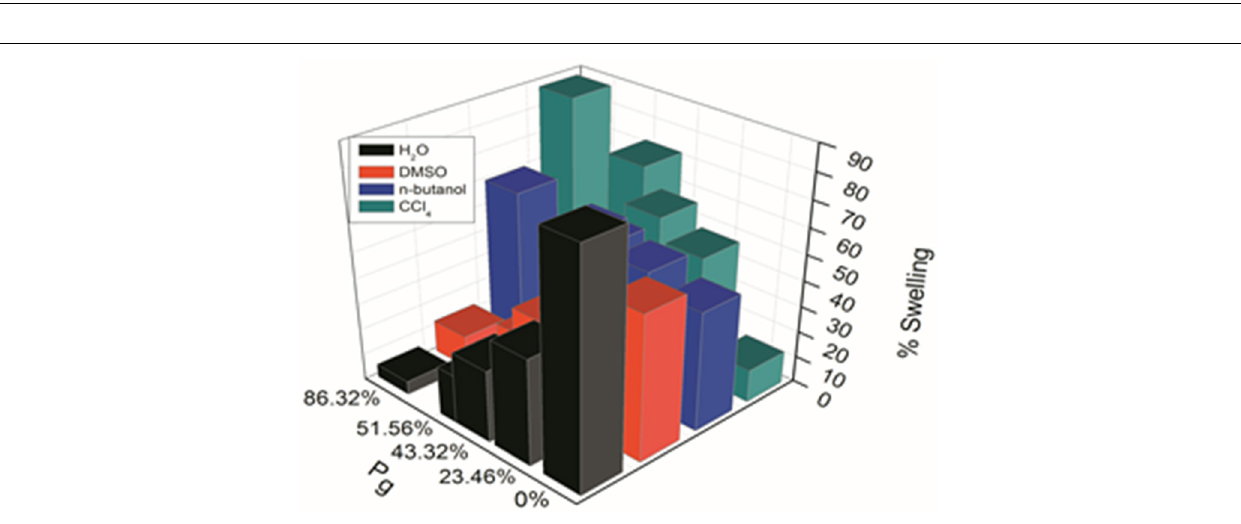
Figure 2 | Swelling behavior of delignified Grewia optiva fiber, dGo-poly(MMA), dGo-poly(MMA-co-EA), and dGo-poly(MMA-co-EMA) at maximum P g in different